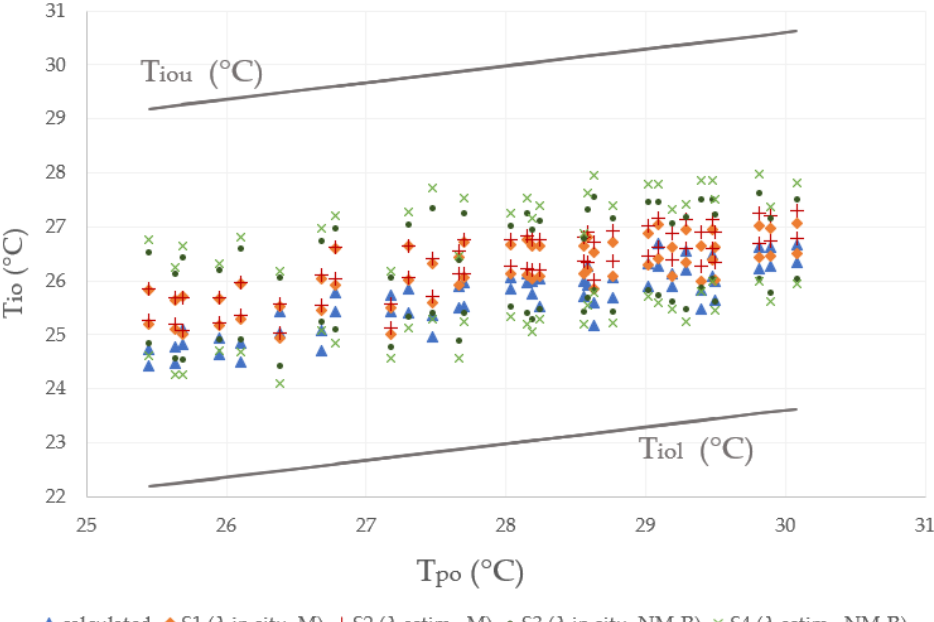
Figure 6. Daily maximum and minimum indoor operative temperature (T io ) values depending on the prevailing outdoor temperature (July 2018). In situ calculated values and simulations.